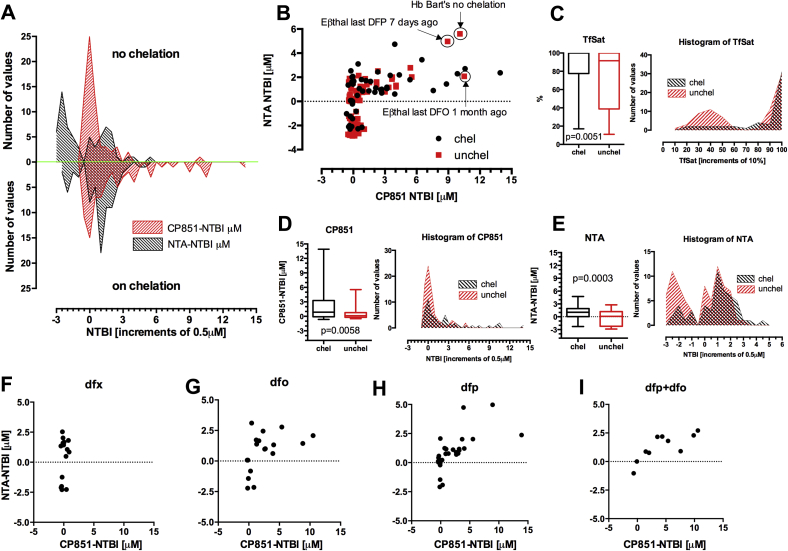
Effect of chelation on method agreement. (A). Comparison of NTBI distributions in patients not chelated (upper panel) and chelated (lower panel), red symbols show the bead CP851 assay and black symbols the NTA assay. (B) Comparison of NTA method vs. bead method in patients with (black) and without (red) chelation, of the outliers marked only the chelation ones were excluded from analysis in panels (C–E). (C) Comparison of TfSat distributions in chelated and unchelated patients seen in B, Mann–Whitney test. (D) Comparison of CP851-NTBI in chelated and unchelated patients seen in B, Mann–Whitney test (E) Comparison of NTA-NTBI in chelated and unchelated patients seen in B, Mann–Whitney test. (F) NTA method vs bead method in patients on deferasirox, no correlation (ns) (G) NTA method vs bead method in patients on desferrioxamine, correlation coefficient r = 0.47 (0.01–0.77), P = 0.05. (H) NTA method vs bead method in patients on deferiprone, correlation coefficient r = 0.63 (0.34–0.81), P = 0.0003. (I) NTA method vs bead method in patients on combination therapy of deferiprone and desferrioxamine, correlation coefficient r = 0.78 (0.3–0.95), P = 0.0076. NTBI, nontransferrin-bound iron; NTA, nitrilotriacetate; TfSat, transferrin saturation. (For interpretation of the references to color in this figure legend, the reader is referred to the Web version of this article.)